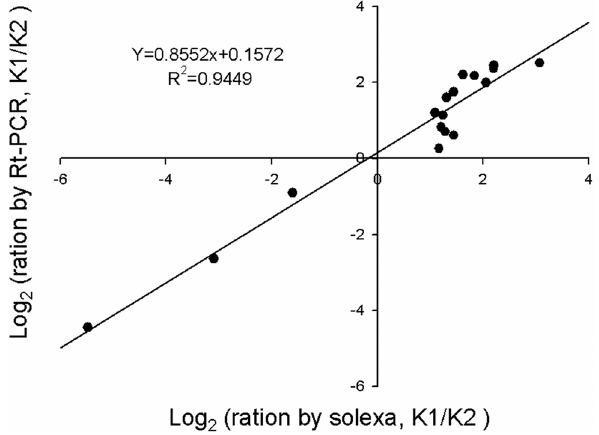
Figure 2. Comparison of the expression ratios of some selected genes using Solexa sequencing and